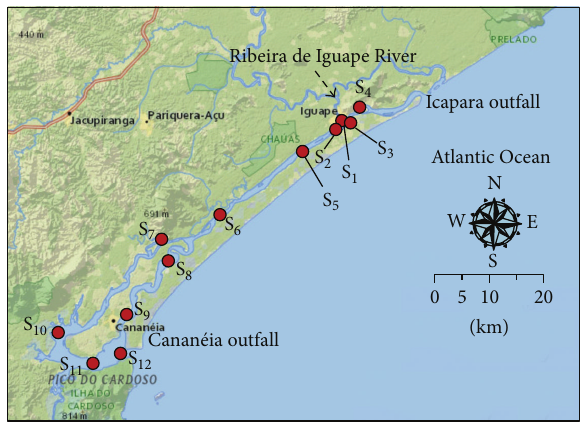
Figure 1: Map of study area showing the 12 sampling stations along the Canan´eia-Iguape estuarine-lagoonal system, located in S˜ao Paulo state (Southeast Brazil). Content may not reflect National Geographic’s current map policy. Sources: National Geographic, Esri, DeLorme, HERE, UNEP-WCMC, USGS, NASA, ESA, METI, NRCAN, GEBCO, NOAA, and Increment P